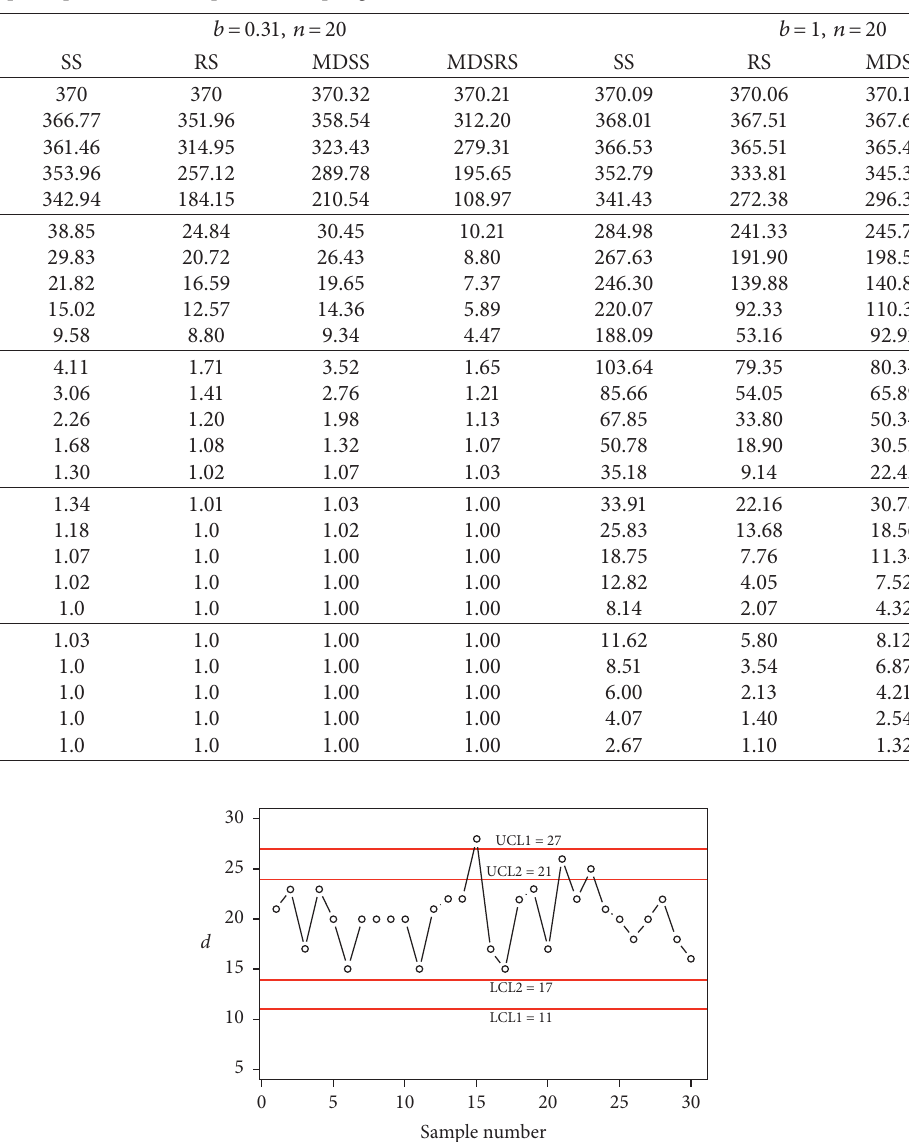
Table 7: Comparison between the BS control chart using single sampling (SS), repetitive sampling (RS), multiple dependent state sampling (MDSS), and multiple dependent state repetitive sampling (MDSRS) methods.